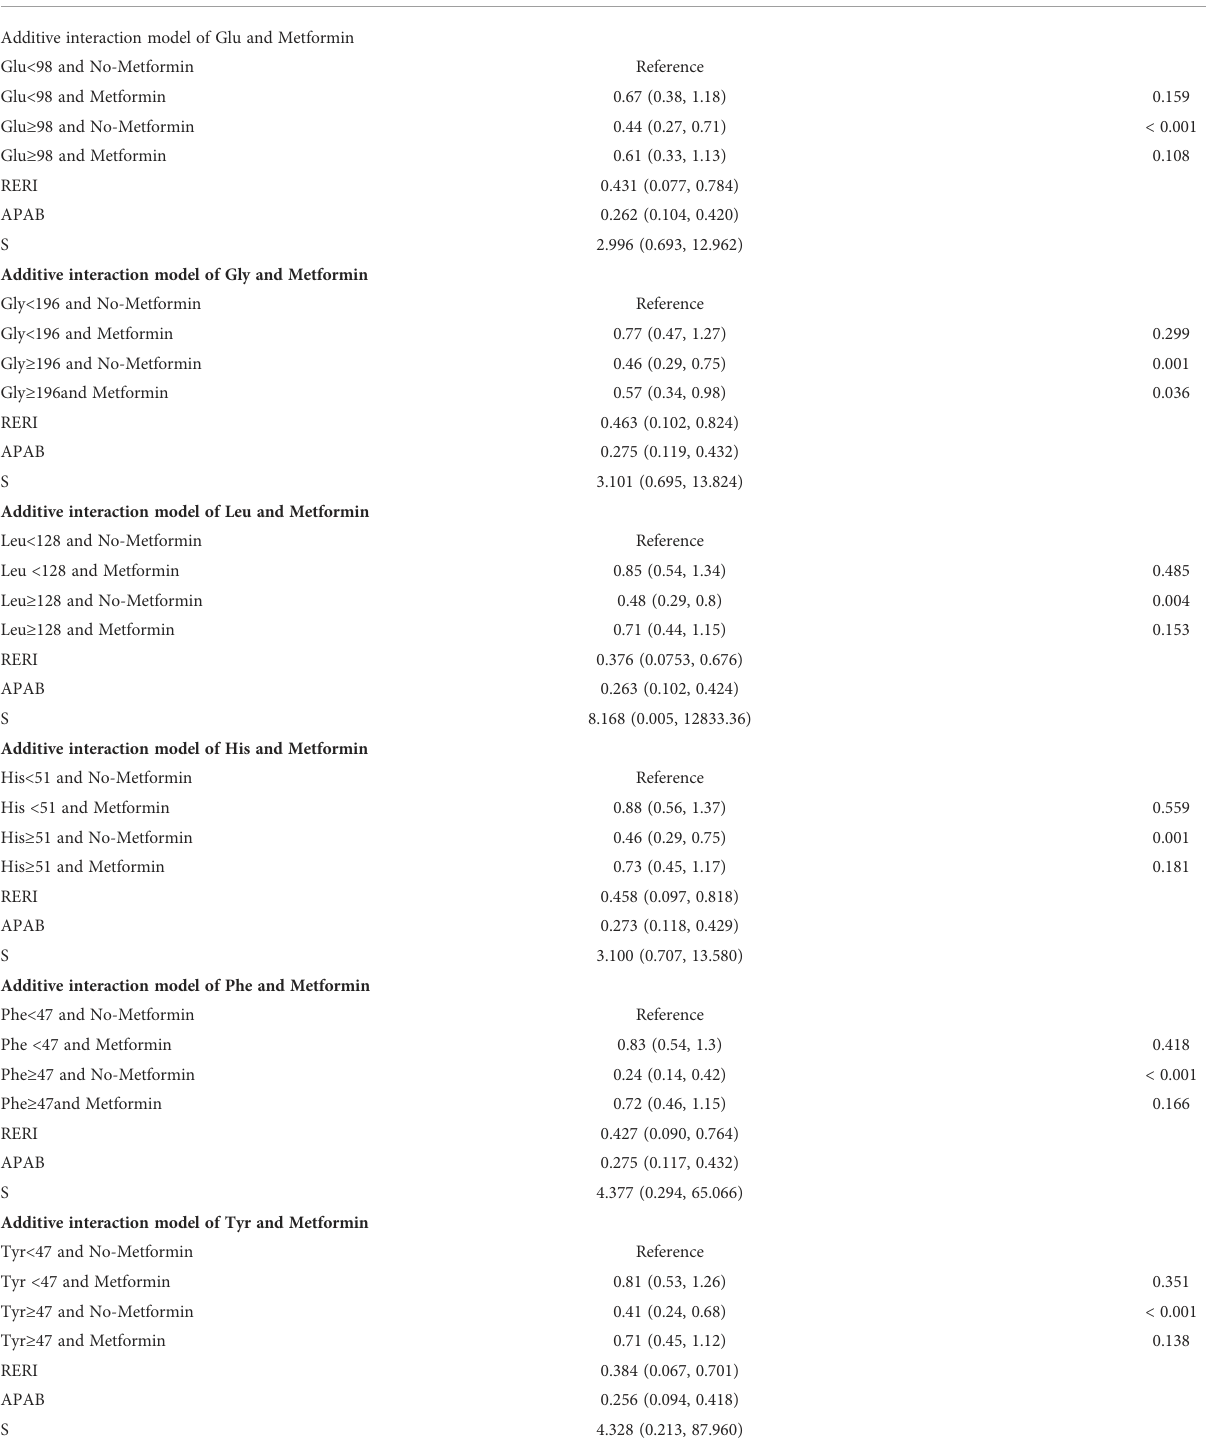
TABLE 3 Two-factor additive interaction between amino acids and